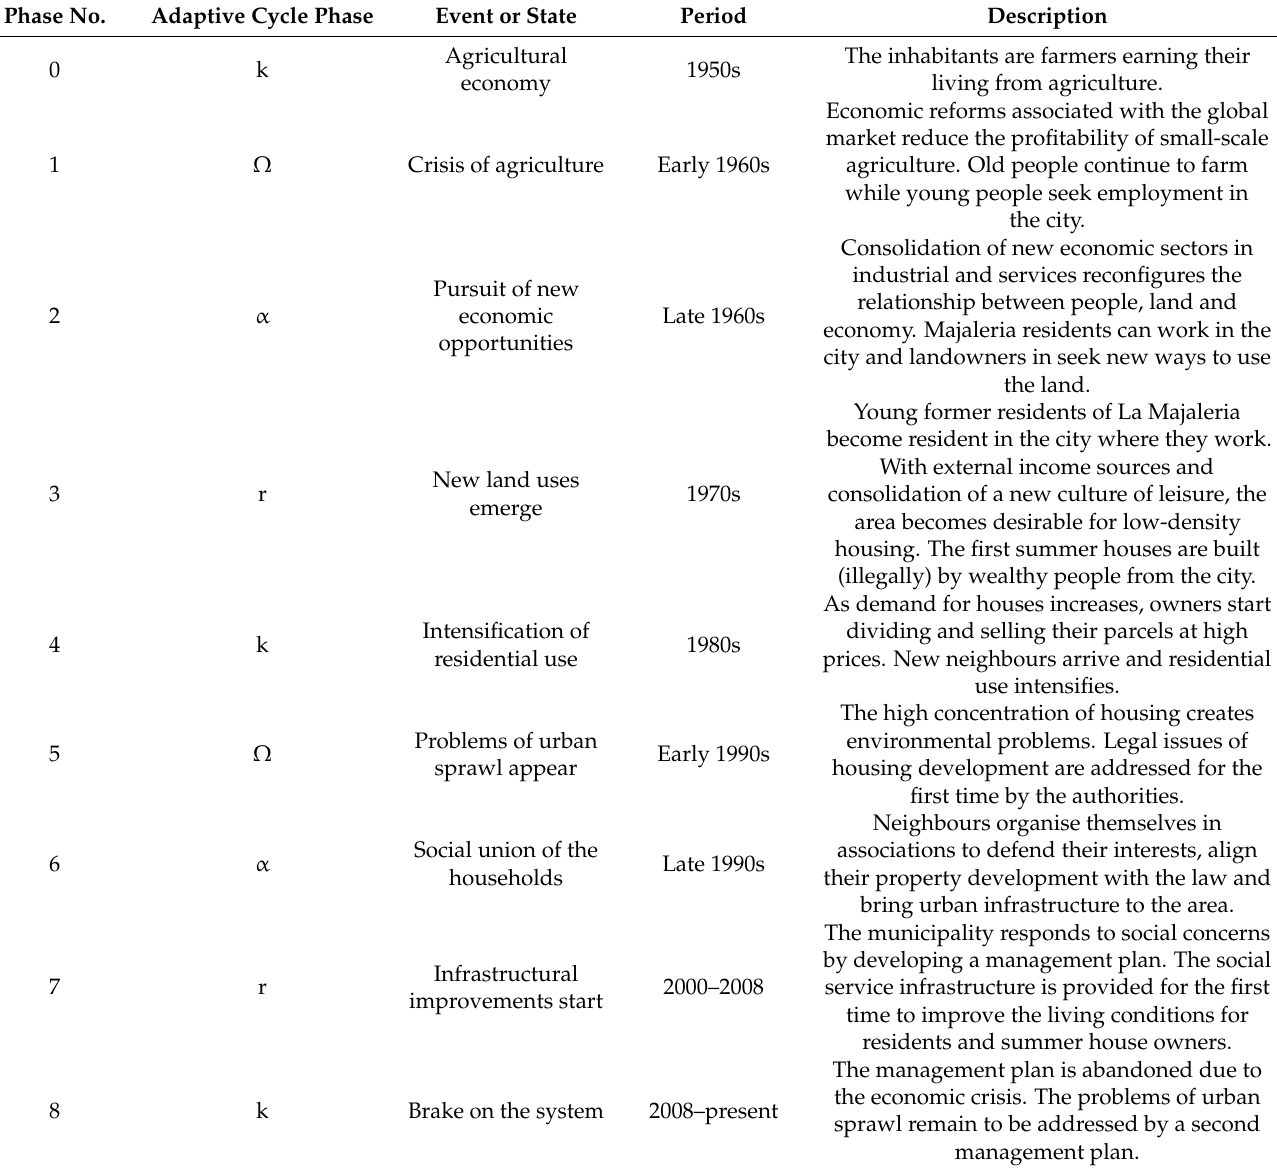
Table 3. Adaptive cycle phases of change in the social system (the lower level of the panarchy) of La Marjaleria social- ecological system. Phase